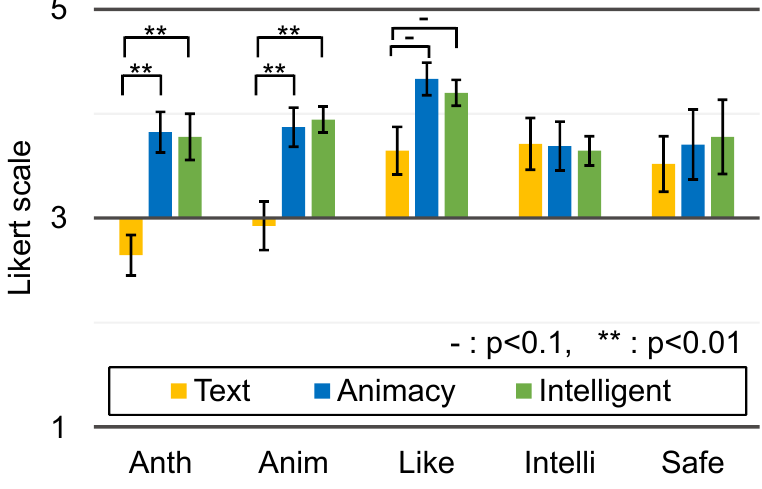
Figure 10. Results of the Godspeed Questionnaire in each